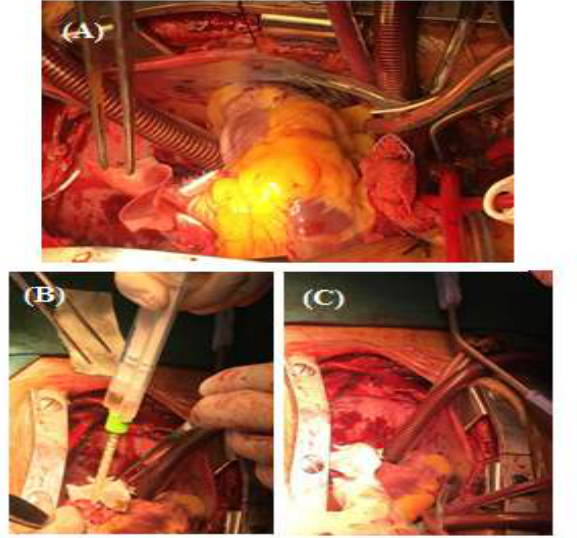
Figure 4: Hemostasis with Surgically and Bio